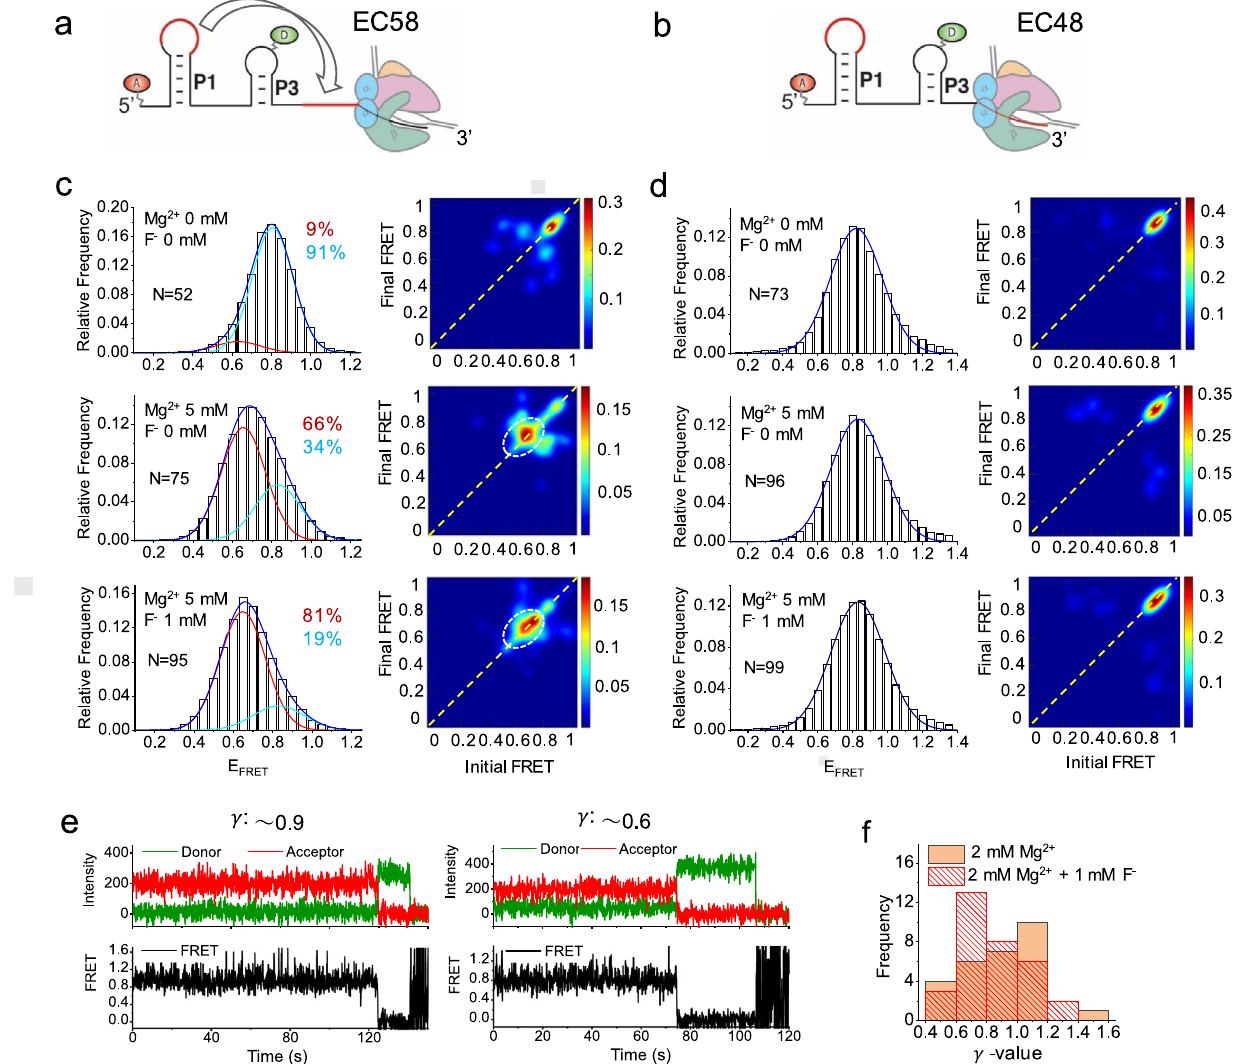
Fig. 5 Effect of Mg 2 + and F - on EC58 and EC48. ( a, b ) Schematics of the fl uoride riboswitch in an elongation complex at transcript lengths of 58 and 48 nucleotides, respectively. ( c, d ) FRET histograms and corresponding TODPs in the absence and presence of Mg 2 + and F - for EC58 and EC48, respectively. The FRET histograms are well fi tted with two Gaussian peaks for EC58 shown in red and cyan for the mid- and high-FRET states, respectively, with the cumulative fi t shown in blue; and a single Gaussian peak for EC48 shown in blue. The percent population of fi tted peaks are shown in respective colors in each histogram panel, and the number of molecules that were analyzed is indicated by “ N ” . A dashed white circle highlights the presence of the SD conformation in TODPs for EC58. ( e ) Representative time traces for EC48 showing similar E FRET values but different γ values, which were determined using fl uorescence intensities of donor ( I D ) and acceptor ( I A ) before (pre) and after (post) photobleaching of the acceptor as γ ¼ ð I EC48 in the absence and presence of F - as